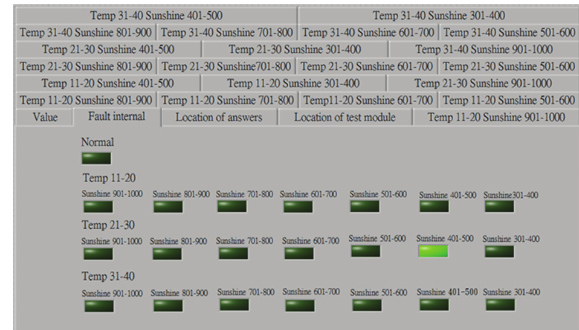
Figure 11: The display interface of fault